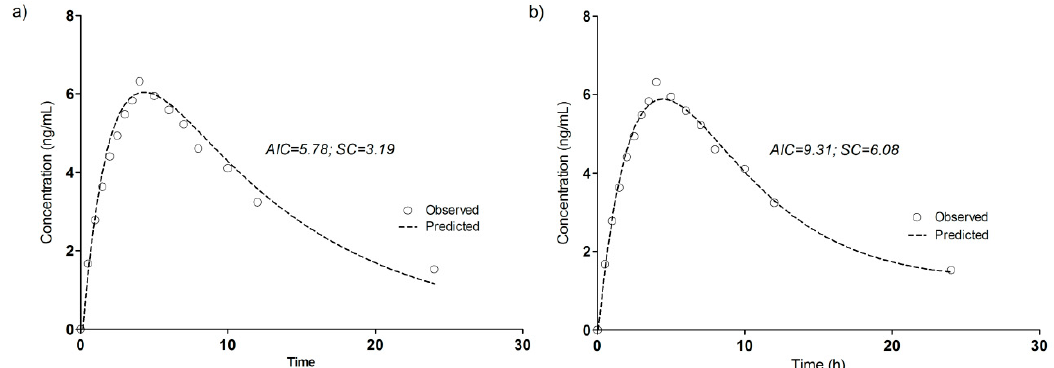
Figure 6. Pharmacokinetic modeling of DTZM mean plasma levels after oral administration of 120 mg DTZ (2 × 60 mg Cardiazem ® tablets) in 19 healthy subjects. ( a ) One-compartment model; ( b ) two-compartment model.